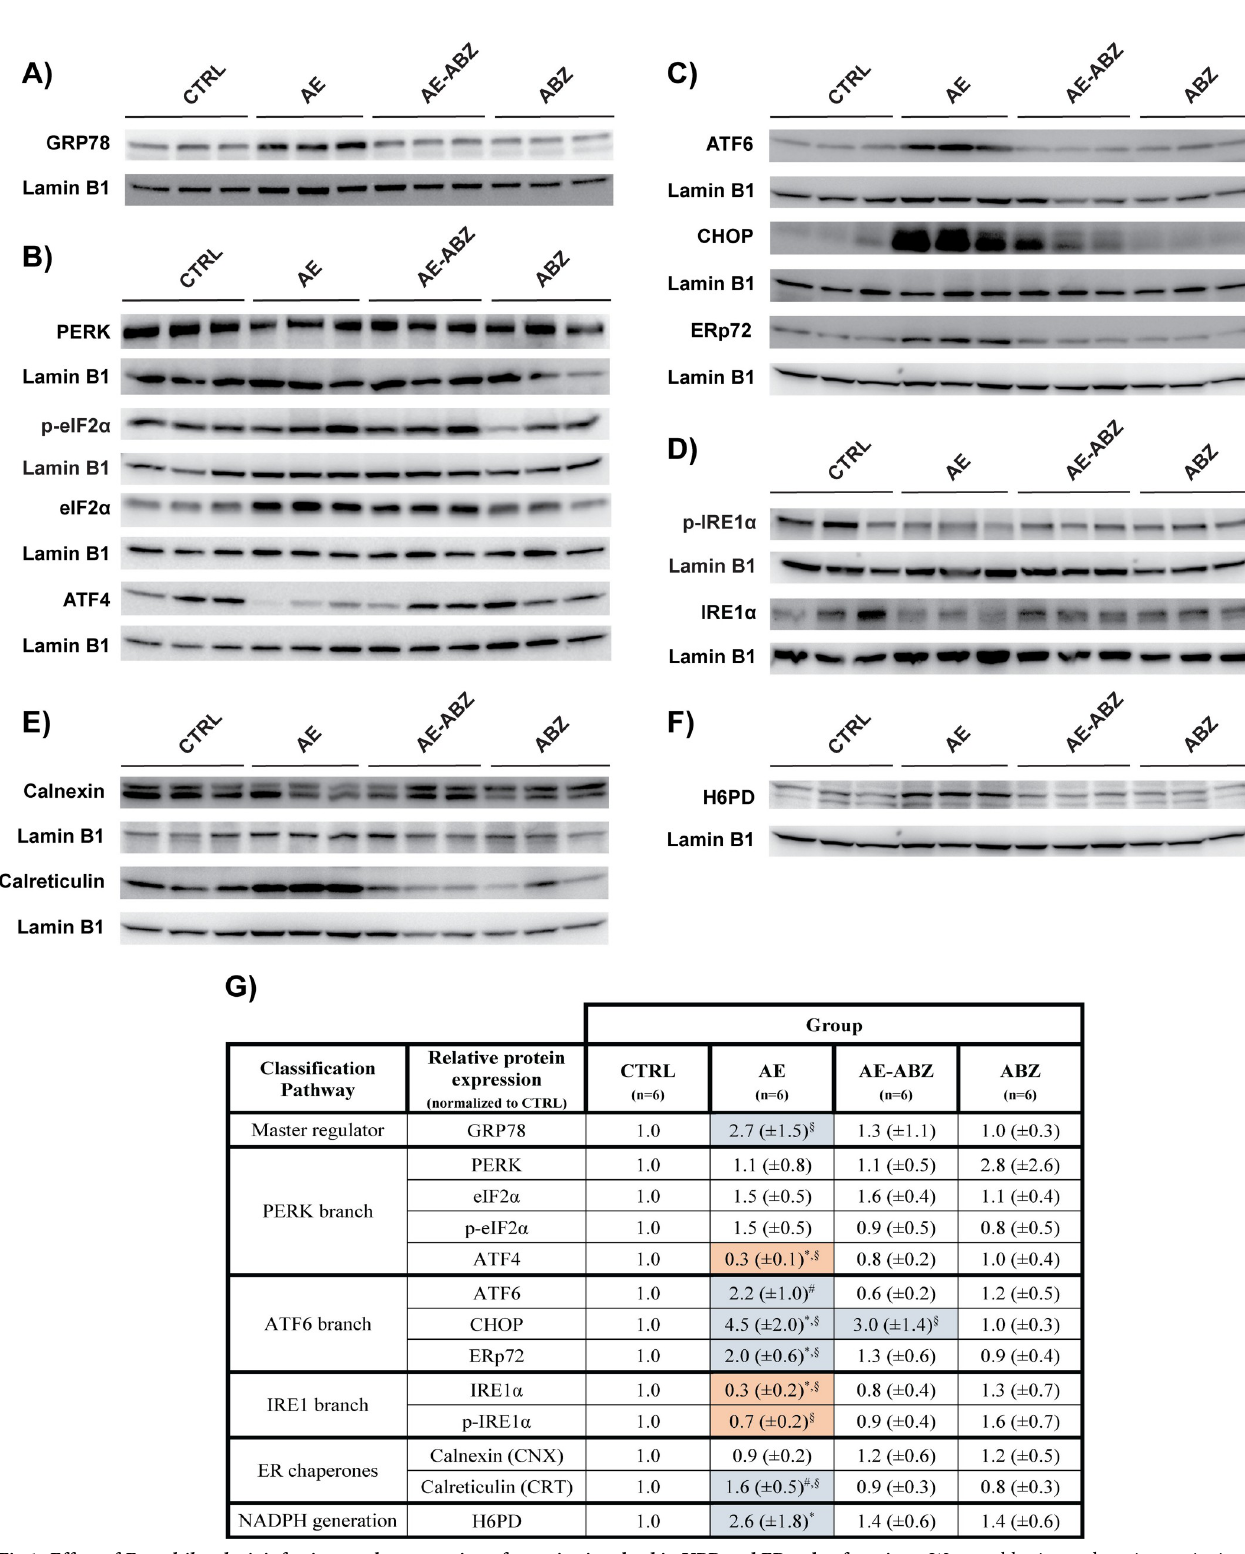
PLOS NeglectedTropical Diseases | https://doi.org/10.1371/journal.pntd.0009192 January 14,